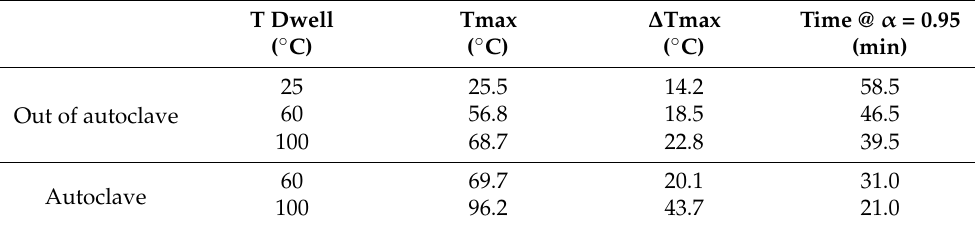
Table 5. Summary of predictions as function of manufacturing technology.